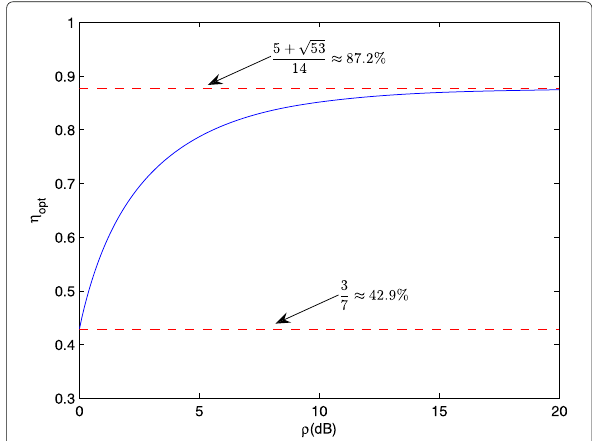
Fig. 4 Optimal relay policy versus SNR ratio under balancing detection accuracy criterion 0, − 5, − 10, − 15 dB). In this figure, all curves are concave,